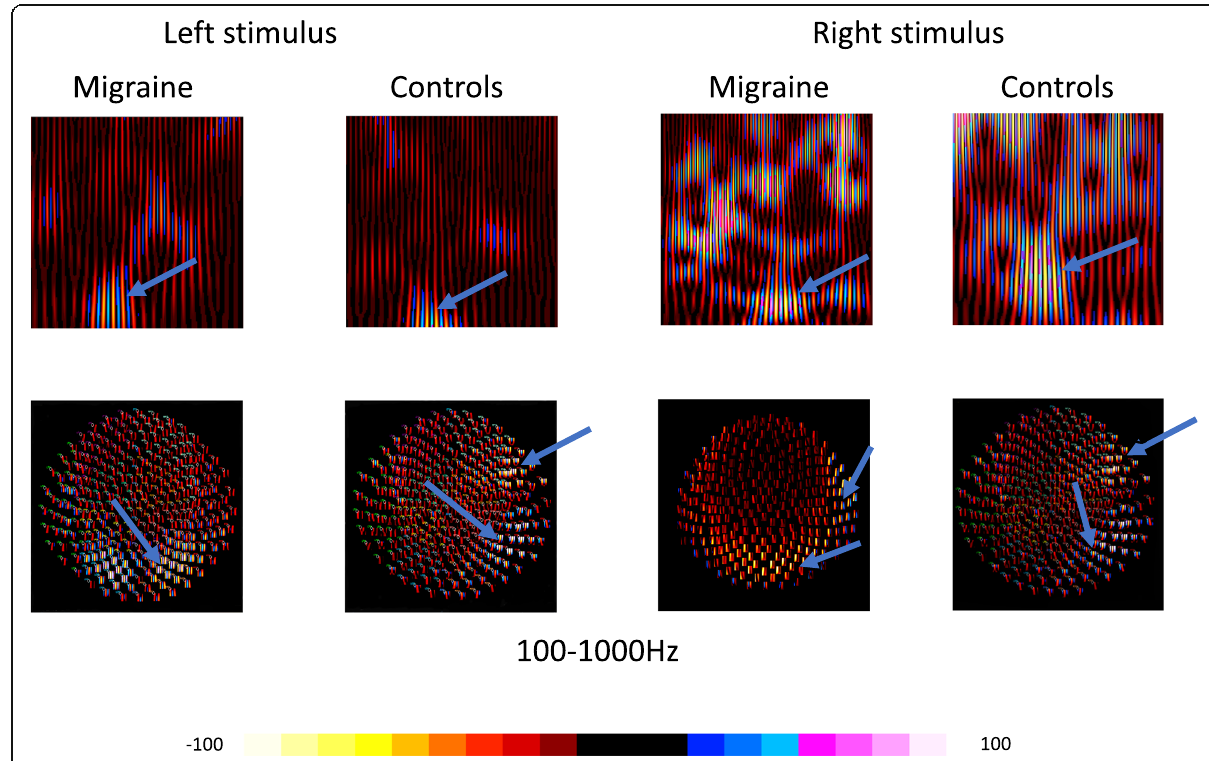
Fig. 3 Time-frequency analysis of visual-evoked magnetic fields (VEFs): An example of the results from time-frequency analysis recorded from a migraine subject and a healthy control. Polarity spectrograms and contour maps (second and fourth) of neuromagnetic signals showed a focal activation (lighting color bar) in 5 – 30 Hz in the low frequency band (50-100Hz) and 100-300Hz in the high frequency range during a visual stimulus. There is increased spectral power in the two frequency bands of 100 – 300 and 500 – 700 Hz in the polarity spectrograms. The contour maps showed a similar activation pattern of visual evoked magnetic fields (VEF) in migraines and controls